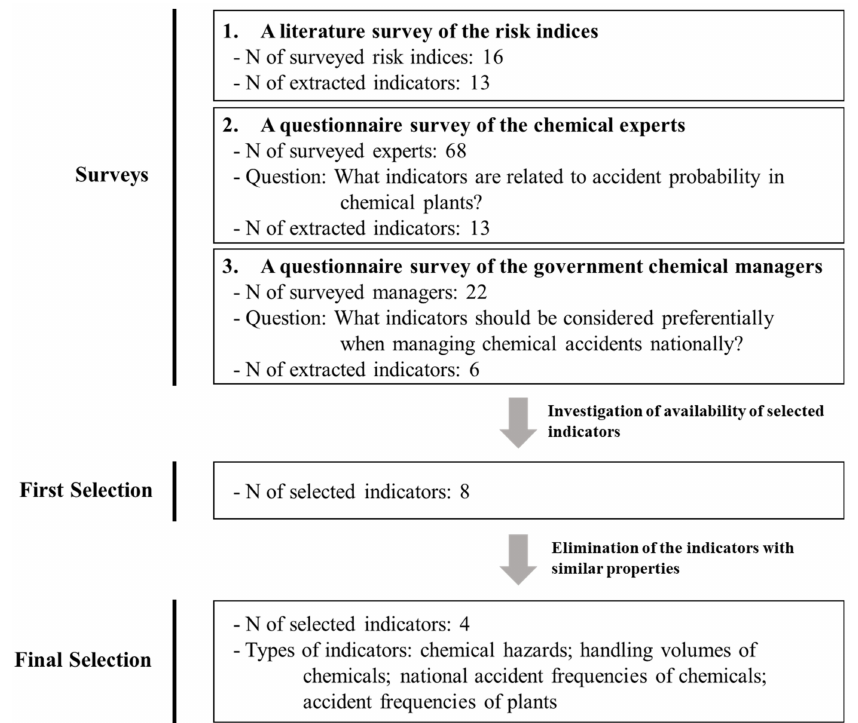
Figure 1. The flow chart of the process of selecting surrogate